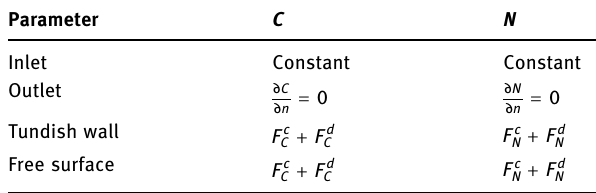
Table 3: Boundary conditions of